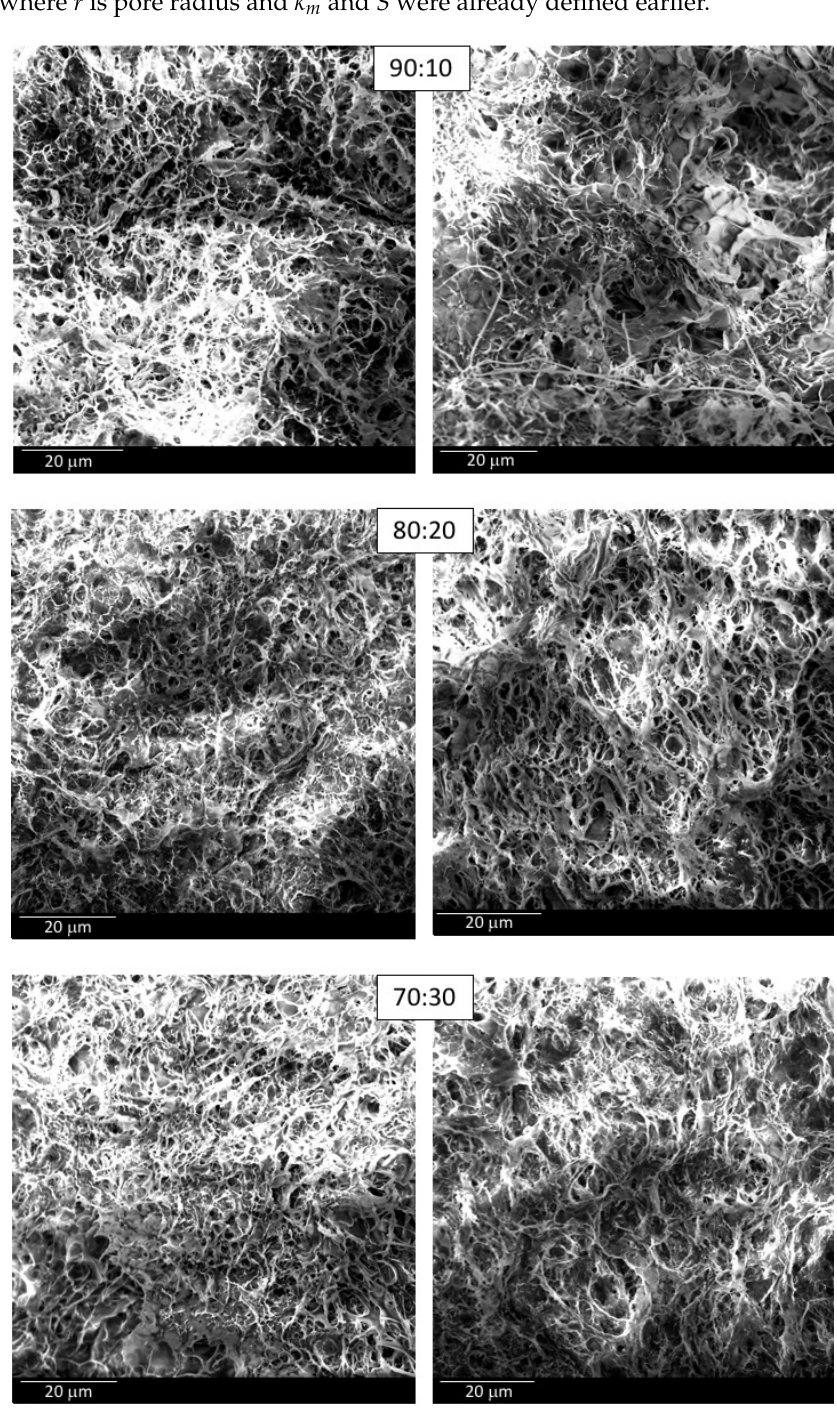
Figure 7. SEM imagines of PVA/MCC-7 (on the left) and PVA/MCC-14 (on the right) hydrogels at different PVA/MCC ratios.